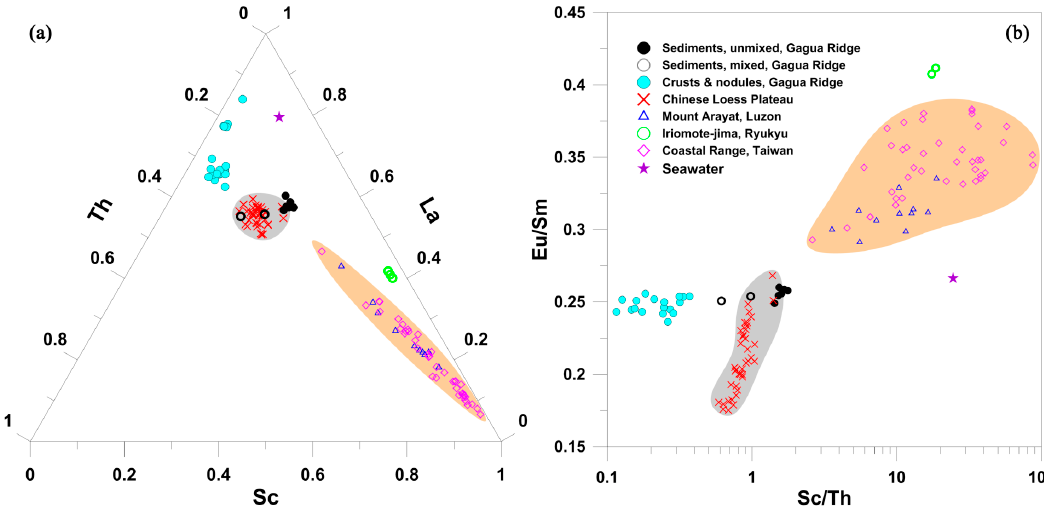
Figure 5. ( a ) Sc-La-Th ternary diagram. ( b ) Eu/Sm vs. Sc/Th diagram. The compositions of Chinese loess and volcanic rocks from Mount Arayat, Iriomote-jima Island, and the Coastal Range of Taiwan are from Ding et al. (2001) [33], Bau and Knittel (1993) [34], Shinjo (1999) [35] and Lai et al. (2008; 2017) [36,37], respectively. Sc contents, Th contents and Eu/Sm ratios of mid-North Pacific seawater from ~4000 m depth are from Amakawa et al. (2007) [64], Roy-Barman et al. (1996) [65], and Zhang and Nozaki (1996) [38], respectively.